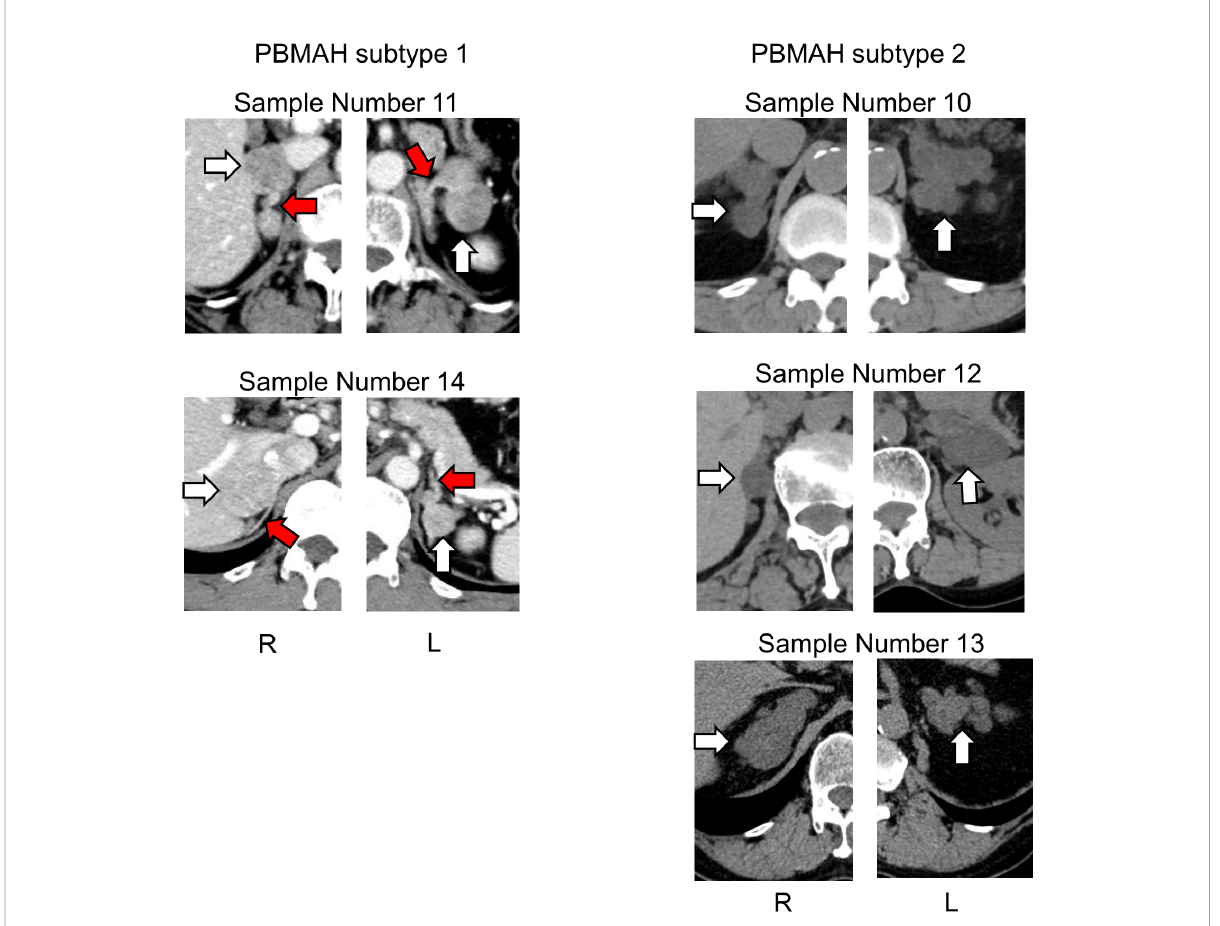
FIGURE 4 Images of adrenal glands of patients with PBMAH. White arrows indicate adrenal lesions. Red arrows show suspected adrenal tissue lesions without hyperplasia in patients with PBMAH subtype